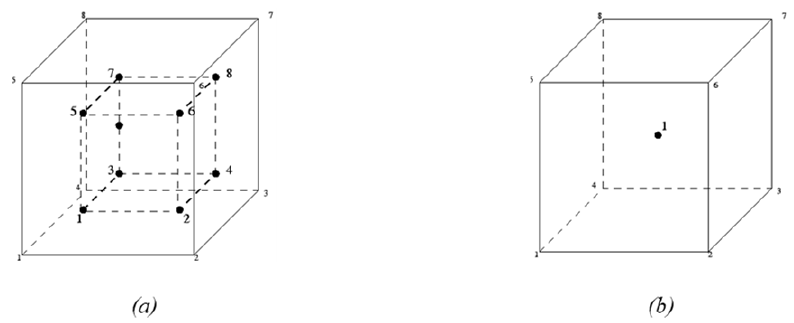
Figure 8. Geometry and integration of brick elements ( a ) C3D8 and ( b ) C3D8R.